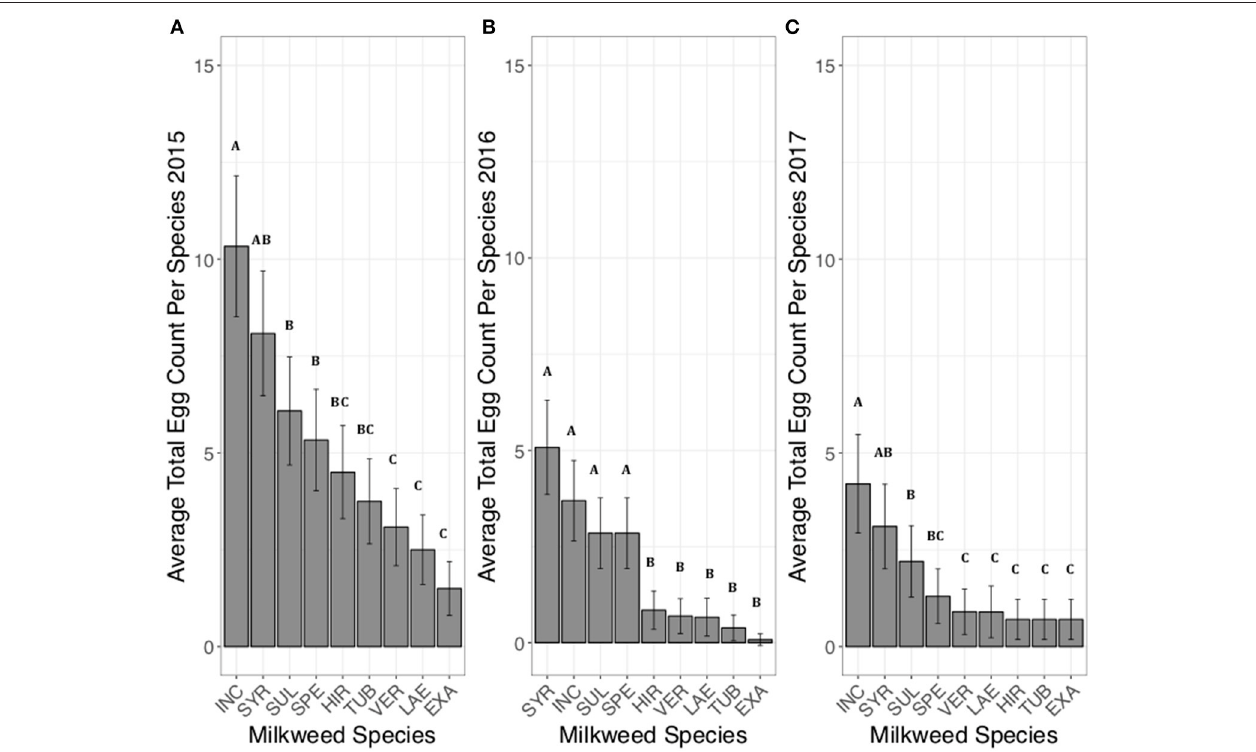
FIGURE 1 | Average eggs counted on each milkweed species over the course of the summer breeding season in 2015 (A) , 2016 (B) , and 2017 (C) . Each bar represents one milkweed species. EXA, A. exaltata ; HIR, A. hirtella ; INC, A. incarnata ; LAE, C. laeve ; SPE, A. speciosa ; SUL, A. sullivantii ; SYR, A. syriaca ; TUB, A. tuberosa ; VER, A. verticillata; error bars represent 95% confidence intervals. N = 12 sites in 2015, 12 sites in 2016, and 10 sites in 2017. Bars that do not share a letter within each panel are significantly different from each other. Females laid more eggs on A. incarnata and A. syriaca than on A. exaltata, A. hirtella, C. laeve, A. tuberosa, and A. verticillata in all years ( p < 0.05). P -values were adjusted using the Tukey method for multiple comparisons.